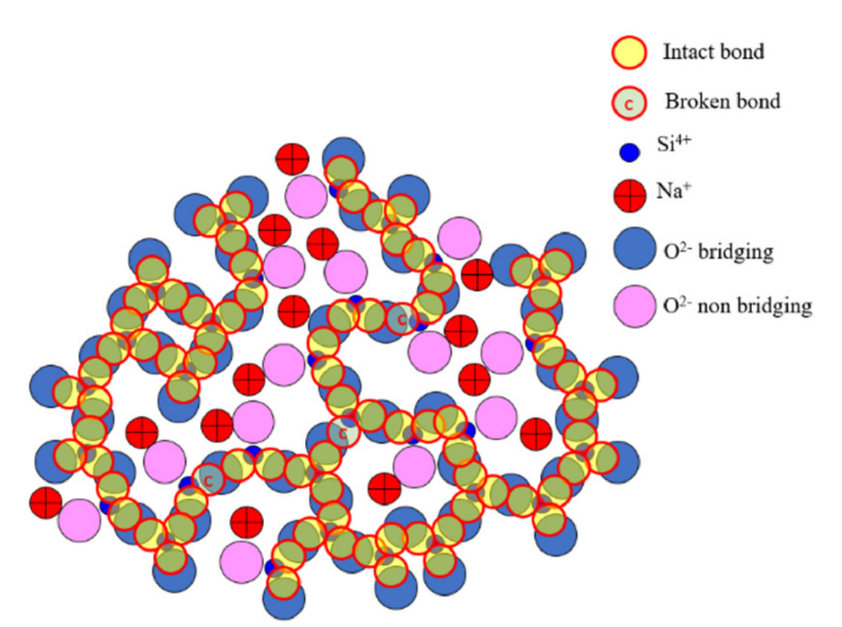
Figure 6. Schematic of congruent set of weakly interacting bonds of a sodium–silicate glass with per- colation ionic channels formed by alkali cations and chains of intact Si-O-Si bonds. Three configurons are explicitly shown. Chains formed by chemical bonds resemble a system of rods and can percolate at a much lower volume fractions φ c (cid:28) θ c than the system of compacted spheres that percolate at φ c = θ c